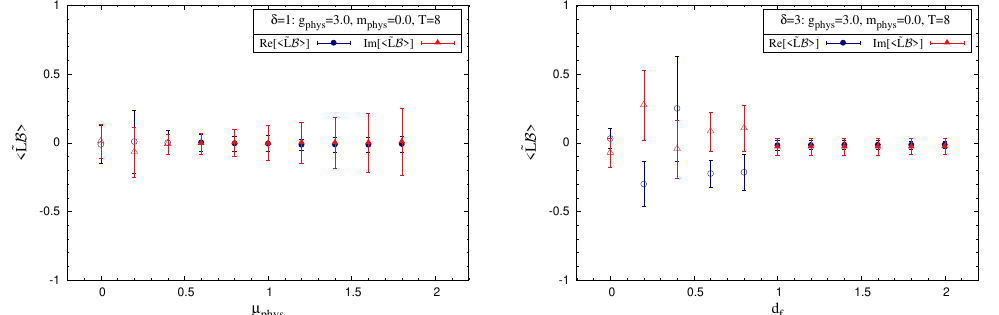
Figure 12 . Expectation values of e L B α for the PT symmetric model on a T = 8 lattice. (Left) Case δ = 1 . (Right) Case δ = 3 . The parameters used are g phys = 3 , m phys = 0 , and α = 0 . 0